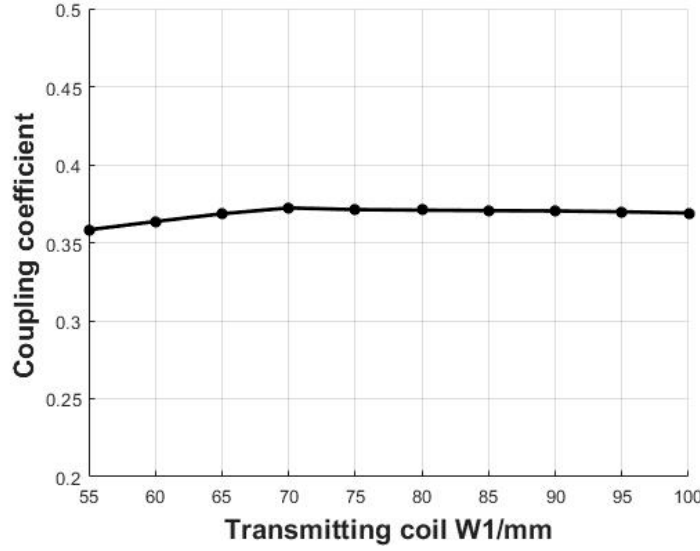
Figure 8. Simulation results of coupling coefficients for different W1.